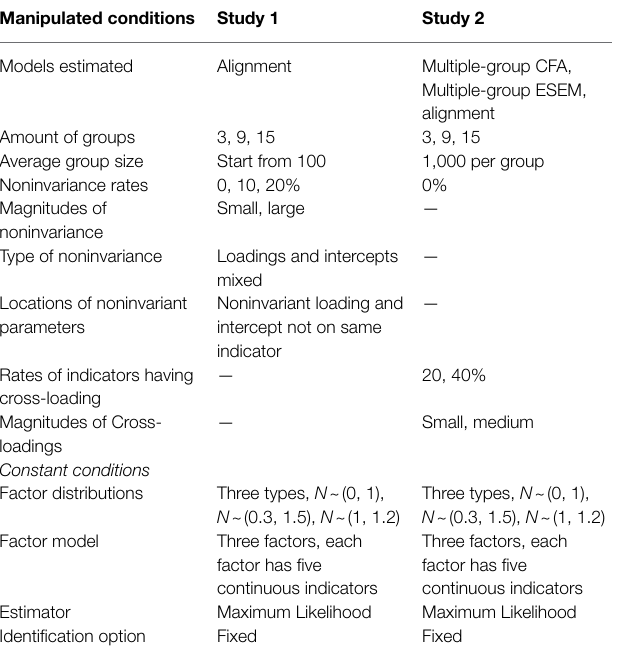
TABLE 2 | Summary of the simulation conditions of the two simulation studies. Manipulated conditions Study